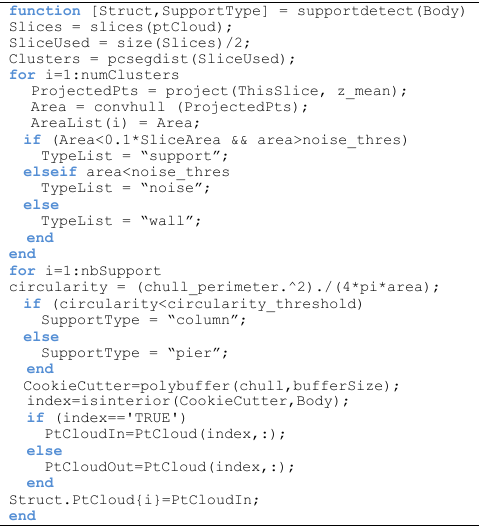
Figure 2. Pseudocode for the support segmentation and classification